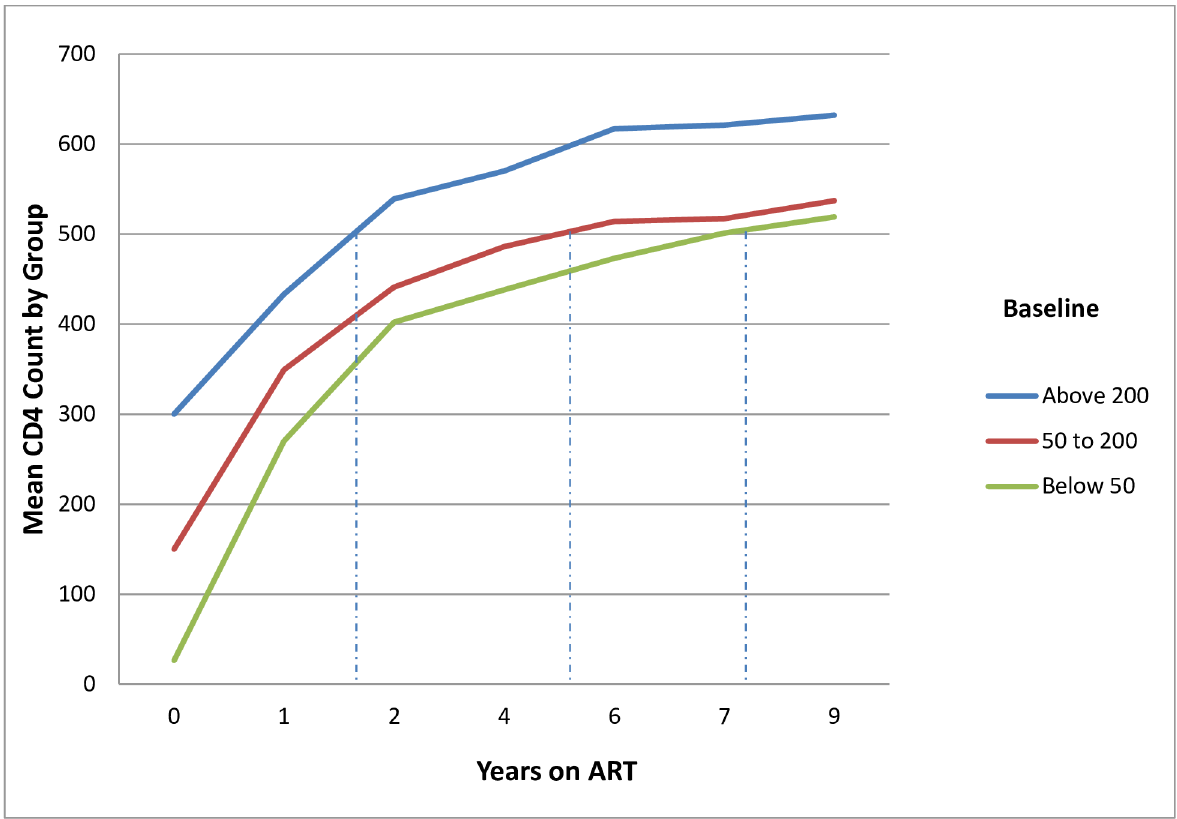
Fig 2. CD4 count trend over time for patients still on ART after 9 years or more, Dawei, 2015.